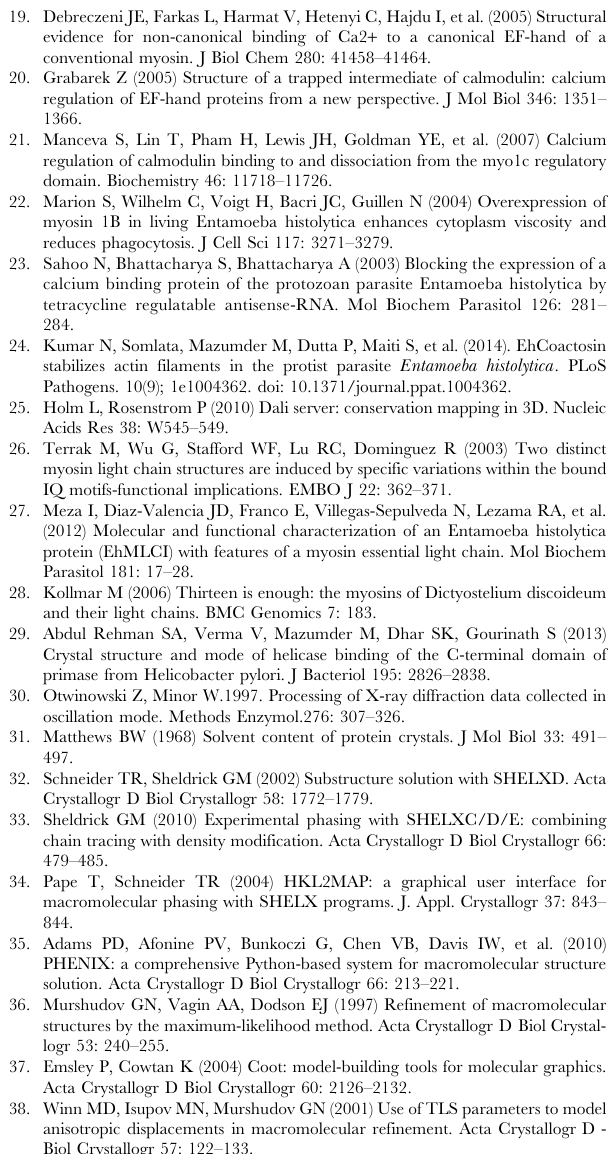
Figure S1 EhCaBP3 was run on myosin 1B IQ motif immobilized surface at concentration of 750 nM. The curve indicates that EhCaBP3 does not interact to myosin 1B IQ motif as the curve is closer to baseline. Figure S2 Electron density map of representative are of EhCaBPs at 1.5 s cut-off. Figure S3 Modelling of EhCaBP5 and IQ motif using FlexPepDock. A) Shows the top 10 peptides superimposed at the binding site. B) A plot of the 200 models created by FlexPepDock, showing Rosetta score (y-axis) vs. RMSD from the